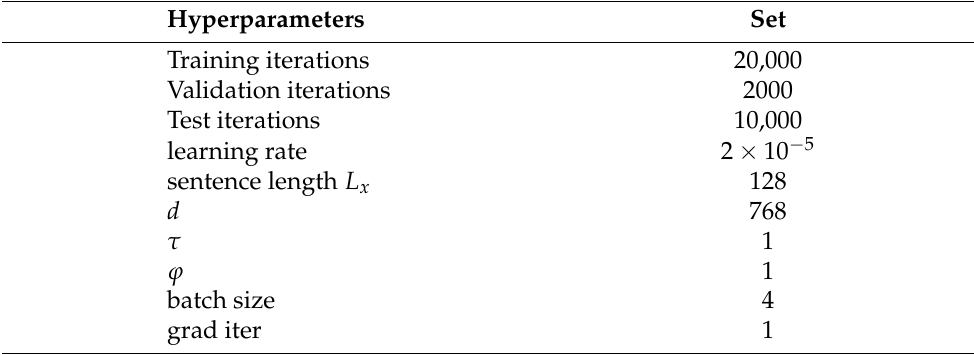
Table 3. Hyperparameters of our